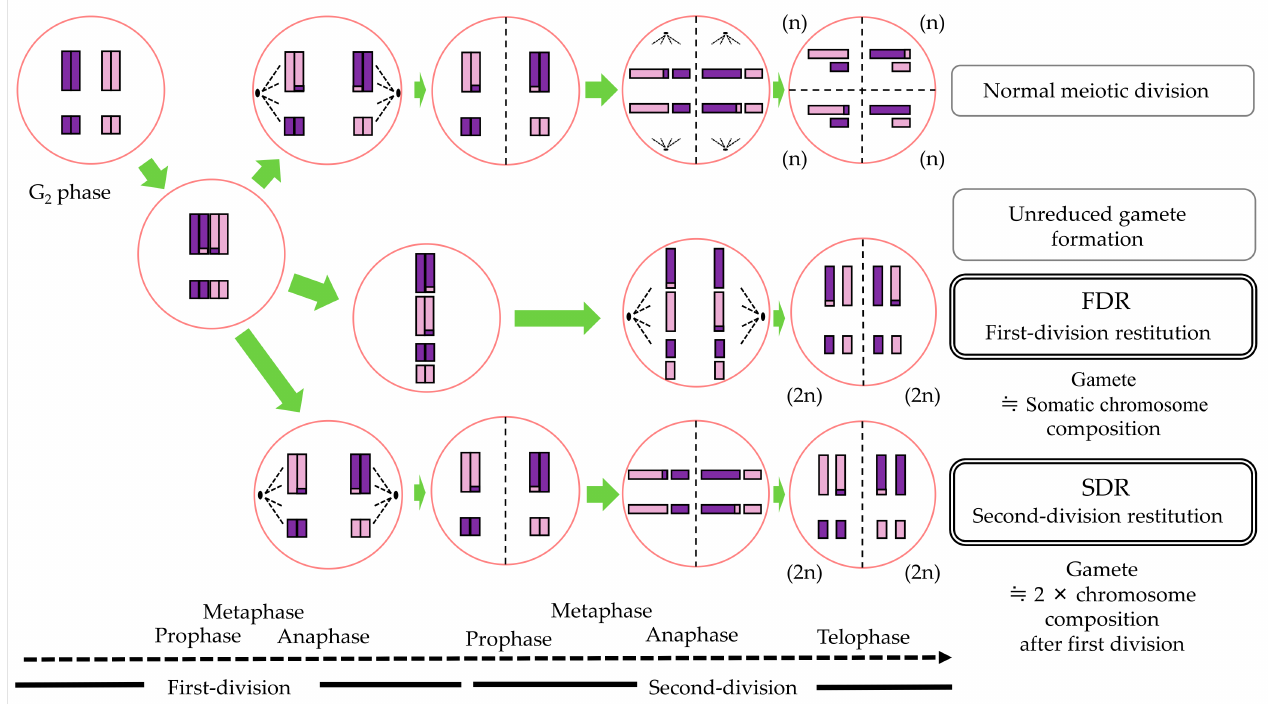
Figure 1. The process of the 2n unreduced gamete formation through two abnormal divisions, FDR and SDR, and the expected chromosome compositions of the 2n unreduced